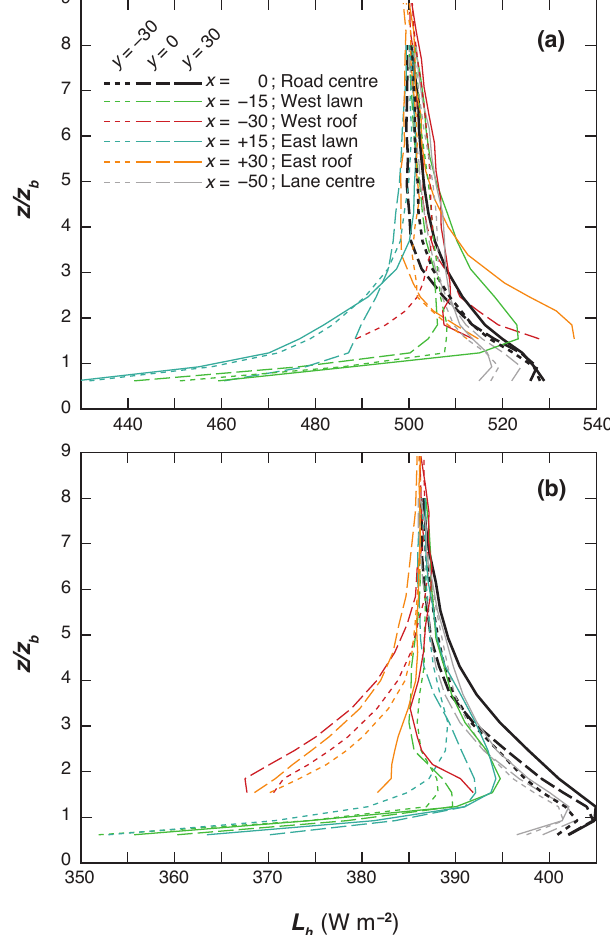
Figure 10. Simulated signals for L h retrieved from hemispher- ical sensors (pyrgeometers) at various heights and locations for (a) 14 September 14:00 and (b) 15 September 00:30. Each graph represents a vertical profile above a specific canyon location as shown in Fig. 3. Note the different scales of the x -axis in panels (a) and (b)